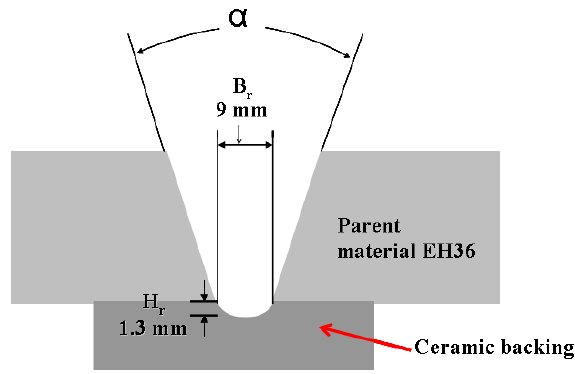
Figure 2. Preparation of components for